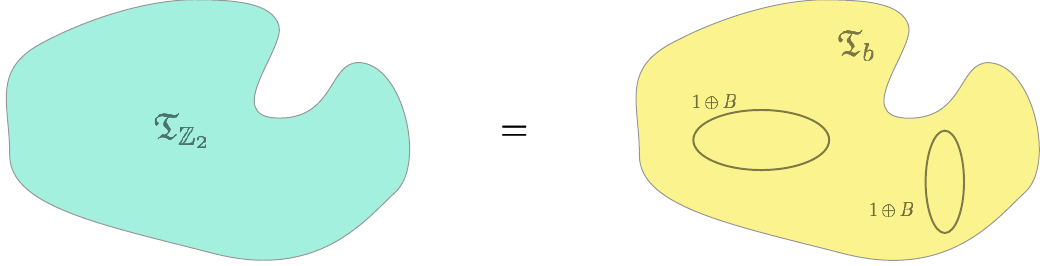
Figure 2 . Wilson lines in Z 2 gauge theory have trivial statistics and can be freely recombined. We use a double-line notation for quasi-particles and line defects to indicate a choice of framing, but the Wilson loops have no framing dependence, i.e. represent bosonic quasi-particles. In general, these abstract properties characterize the quasi-particle generators B of non-anomalous Z 2 1-form symmetries.